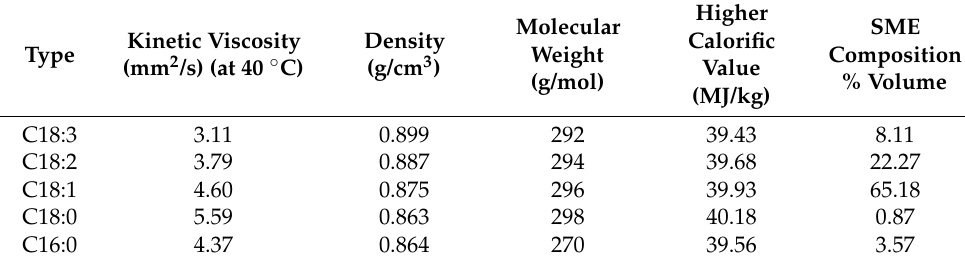
Table 2. Physical properties of FAMEs present.